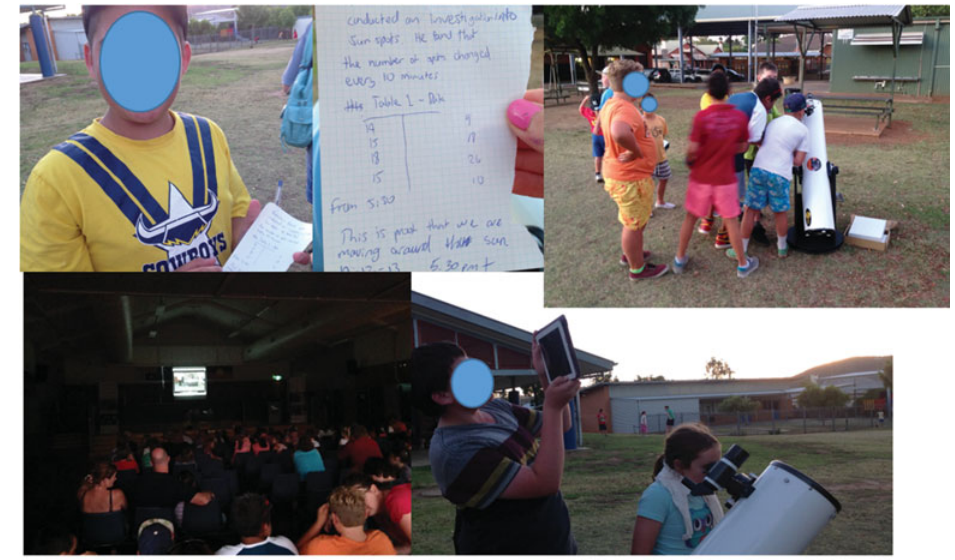
(Colour online) Community event photo